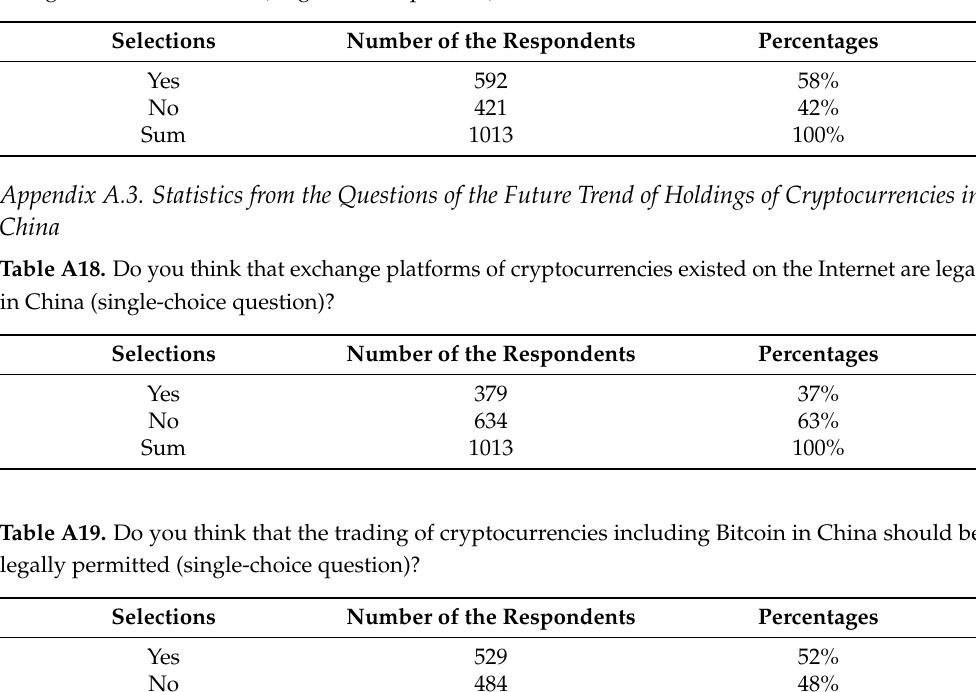
Table A17. Will you accept that your partners use cryptocurrencies in the business when you are doing business with them (single-choice question)?